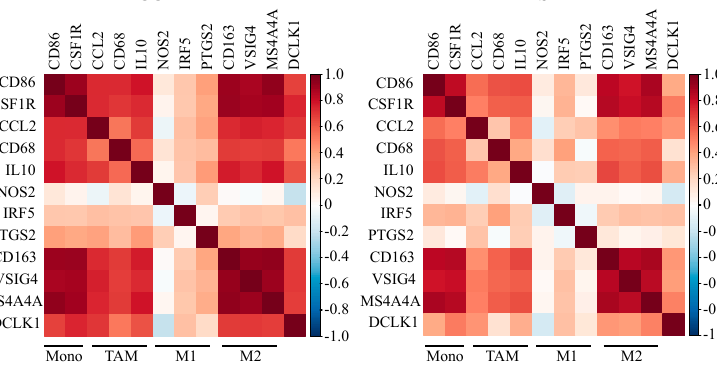
Figure 4. DCLK1 expression in tumor tissues correlates with macrophage polarization in COAD and STAD. Correlations analysis demonstrates that DCLK1 expression is significantly positively correlated with gene markers of monocytes (CD86 and CSF1R), TAMs (CCL2, CD68, and IL10), and M2 (CD163, VSIG4, and MS4A4A), but is not with gene markers of M1 (NOS2, IRF5, and PTGS2) in COAD ( A ) and STAD ( B ).